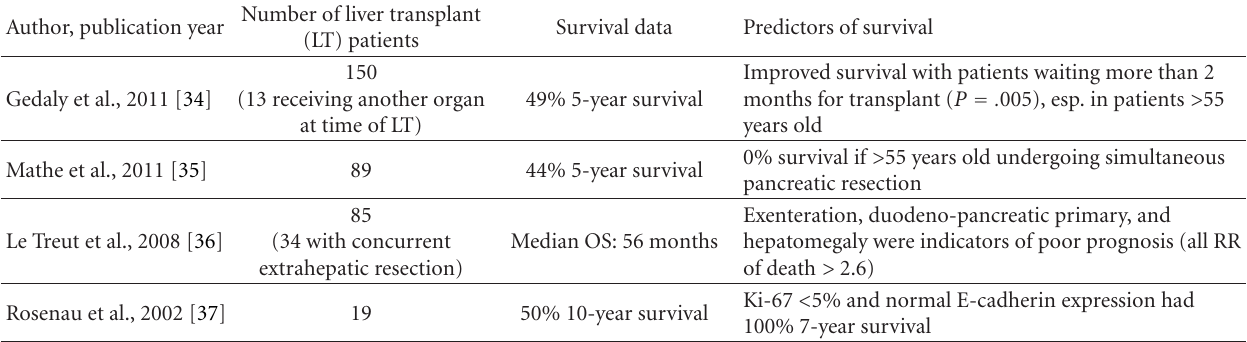
Table 4: Summary of outcomes for liver transplantation for neuroendocrine